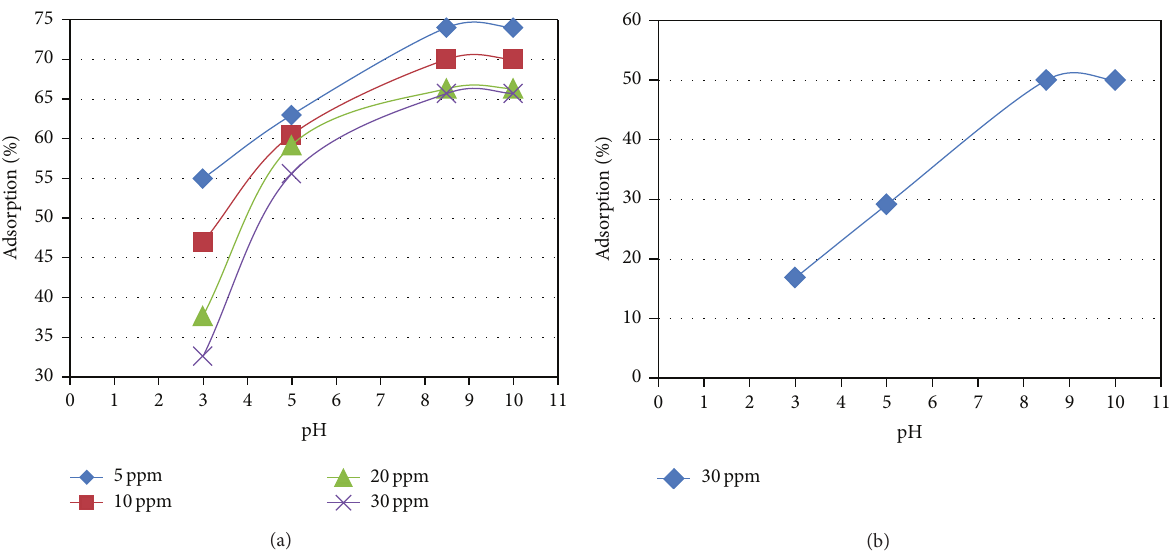
Figure 9: (a) Effect of pH on basic orange dye adsorbed % (contact time = 30 min, CNTs dosage = 100mg/L). (b) Effect of pH on methyl violet dye adsorbed % (contact time = 40min, CNTs dosage = 50 mg/L).